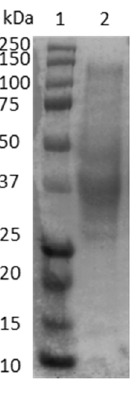
C D Figure 1. SDS-PAGE: Lane 1: low-molecular-weight standard (Precision Plus Protein, Bio-Rad); Lane 2: naringinase diluted 80 times in distilled water.